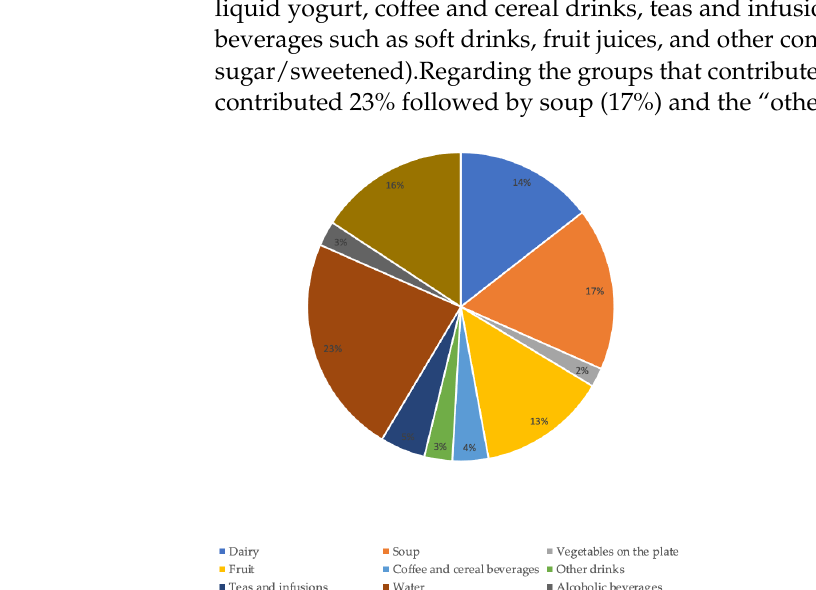
Figure 1. Contribution of food and beverage groups to total water intake.